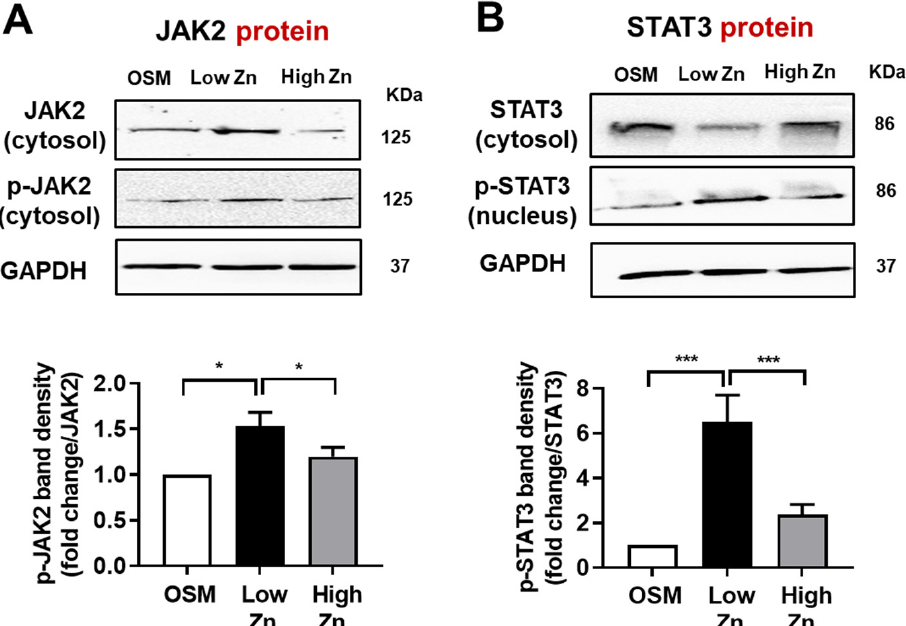
Figure 4. Effects of low Zn on protein expression of JAK2, p-JAK2, STAT3, p-STAT3 in MC3T3-E1 cells. ( A , B ) Protein expression of JAK2, p-JAK2, STAT3, and p-STAT3 in MC3T3-E1 cells treated with either low or high Z nwere analyzed by Western blotting. GAPDH was utilized as loading control for protein normalization. Data represent means ± SEM. The statistical significance between values for each group was assessed by Dunnett’s t -test. *** p < 0.001 between OSM, high Zn, and low Zn groups; * p < 0.05 between OSM, high Zn, and low Zn groups.